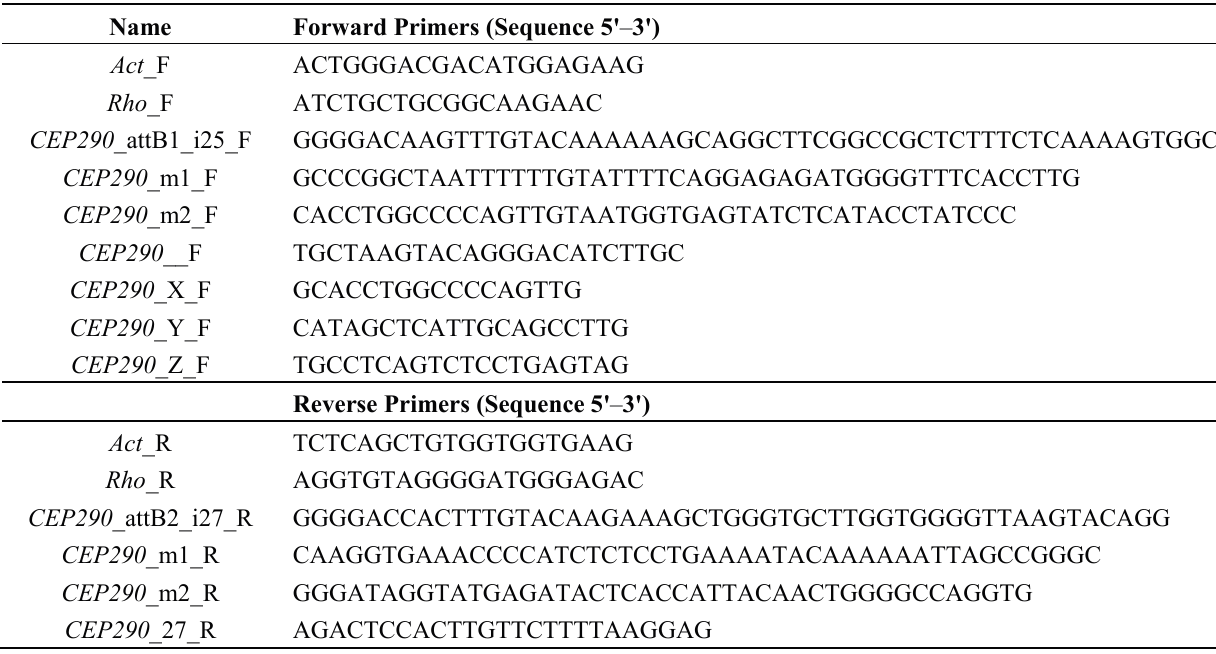
Table 1. Oligonucleotide